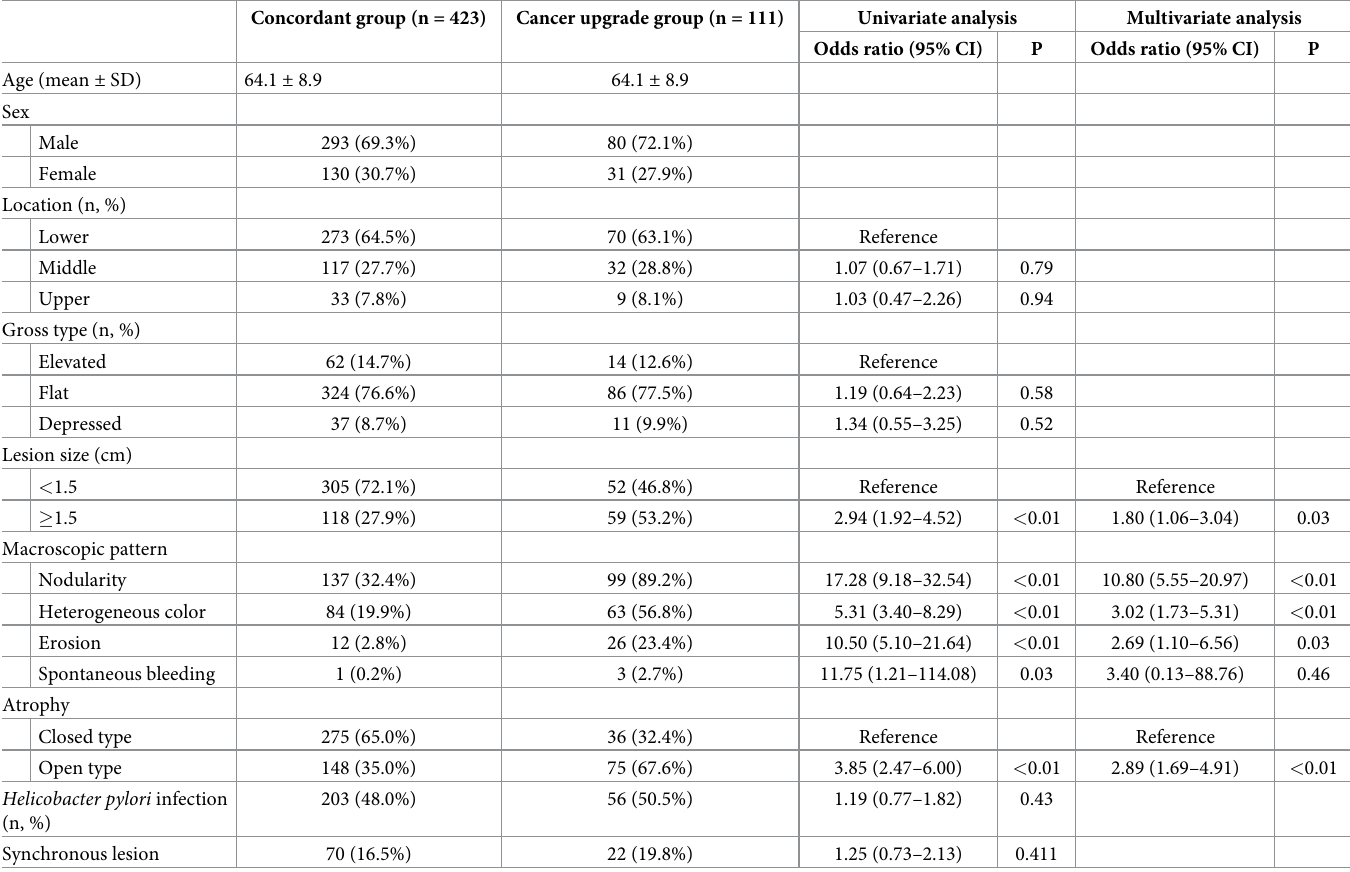
Table 2. Risk factors associated with histological upgrade to early gastric